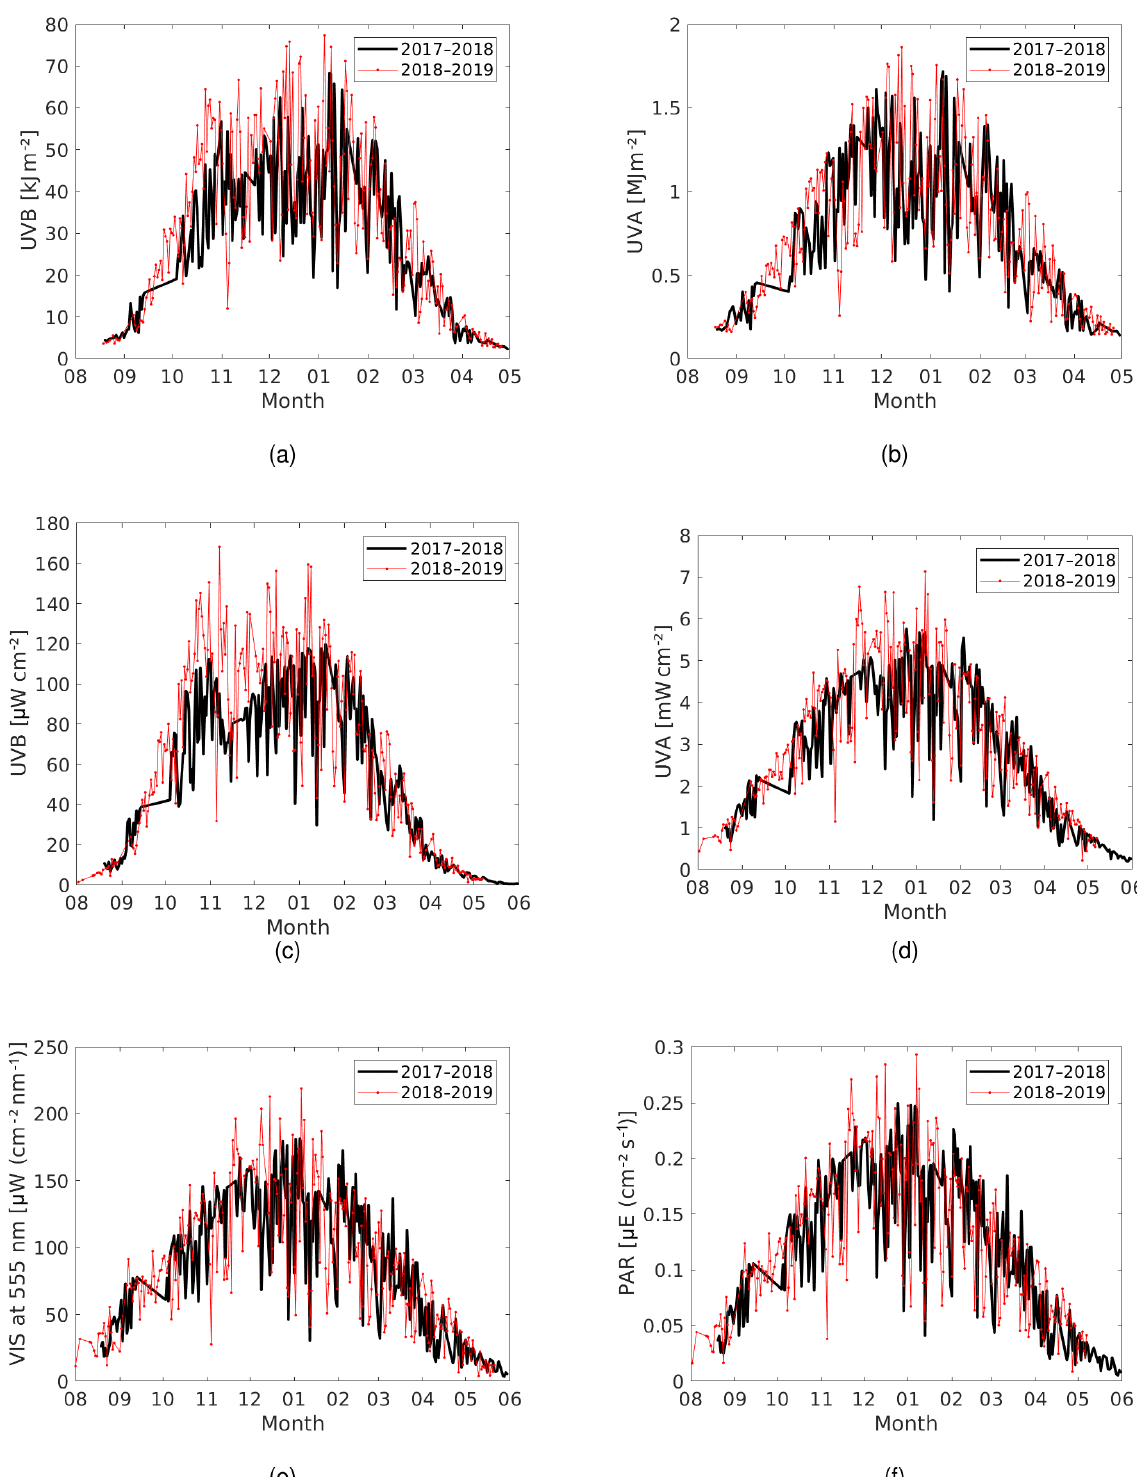
Figure 7. UV and visible radiation time series for the months August–May during the periods 2017–2018 and 2018–2019. (a) UVB daily dose, (b) UVA daily dose, (c) UVB daily maximum, (d) UVA daily maximum, (e) daily maximum VIS at 555nm and (f) PAR daily